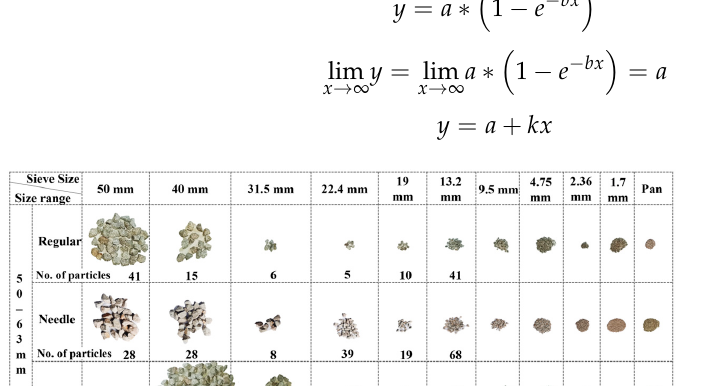
Table 3. The fitted coefficient values of Equations (7) and (9) for distinctly shaped single-size bal- lasts.